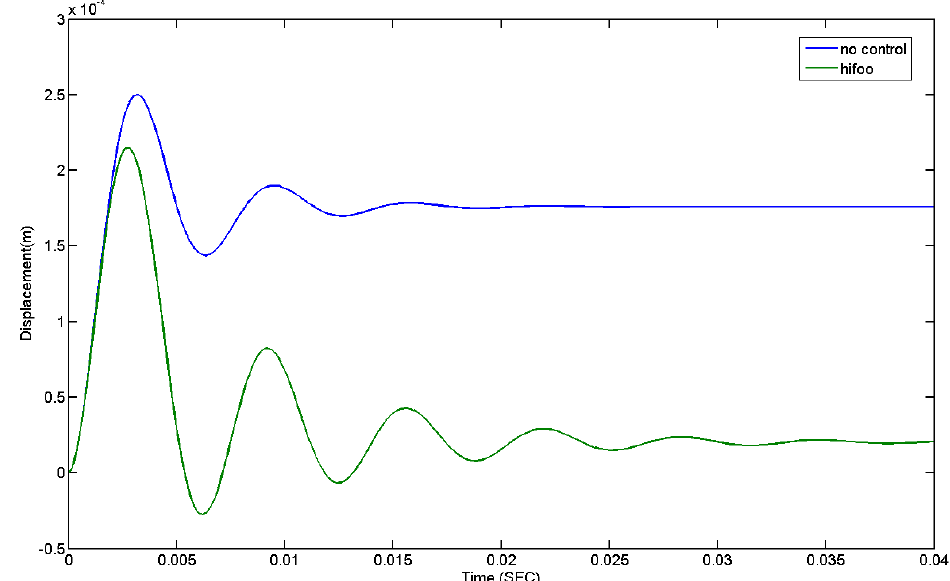
Figure 9. Displacement of the free end of the structure with and without Hifoo.